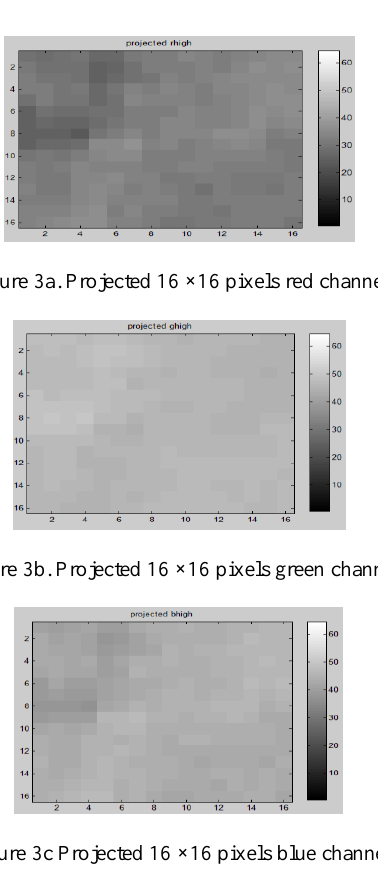
Figure 6. Downsampled 4 × 4 pixels multispectral data based on second case.